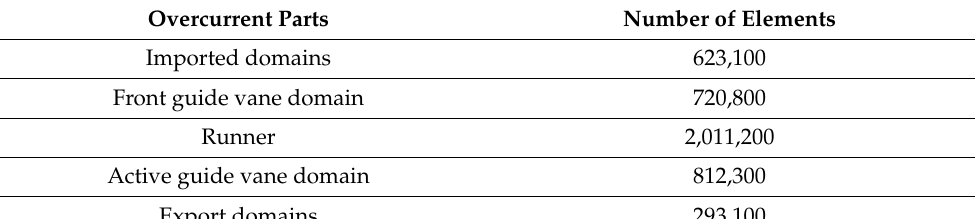
Figure 2. Grid independence verification: A4.2 × 10 6 B4.46 × 10 6 C5.2 × 10 6 . Table 2. The number of grids in each computational domain of the axial-flow pump.